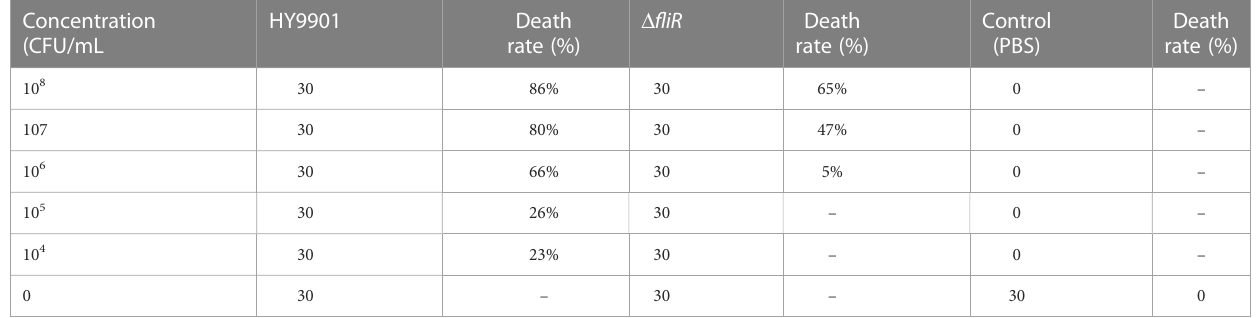
TABLE 1 Primers used for the PCR of this experiment.